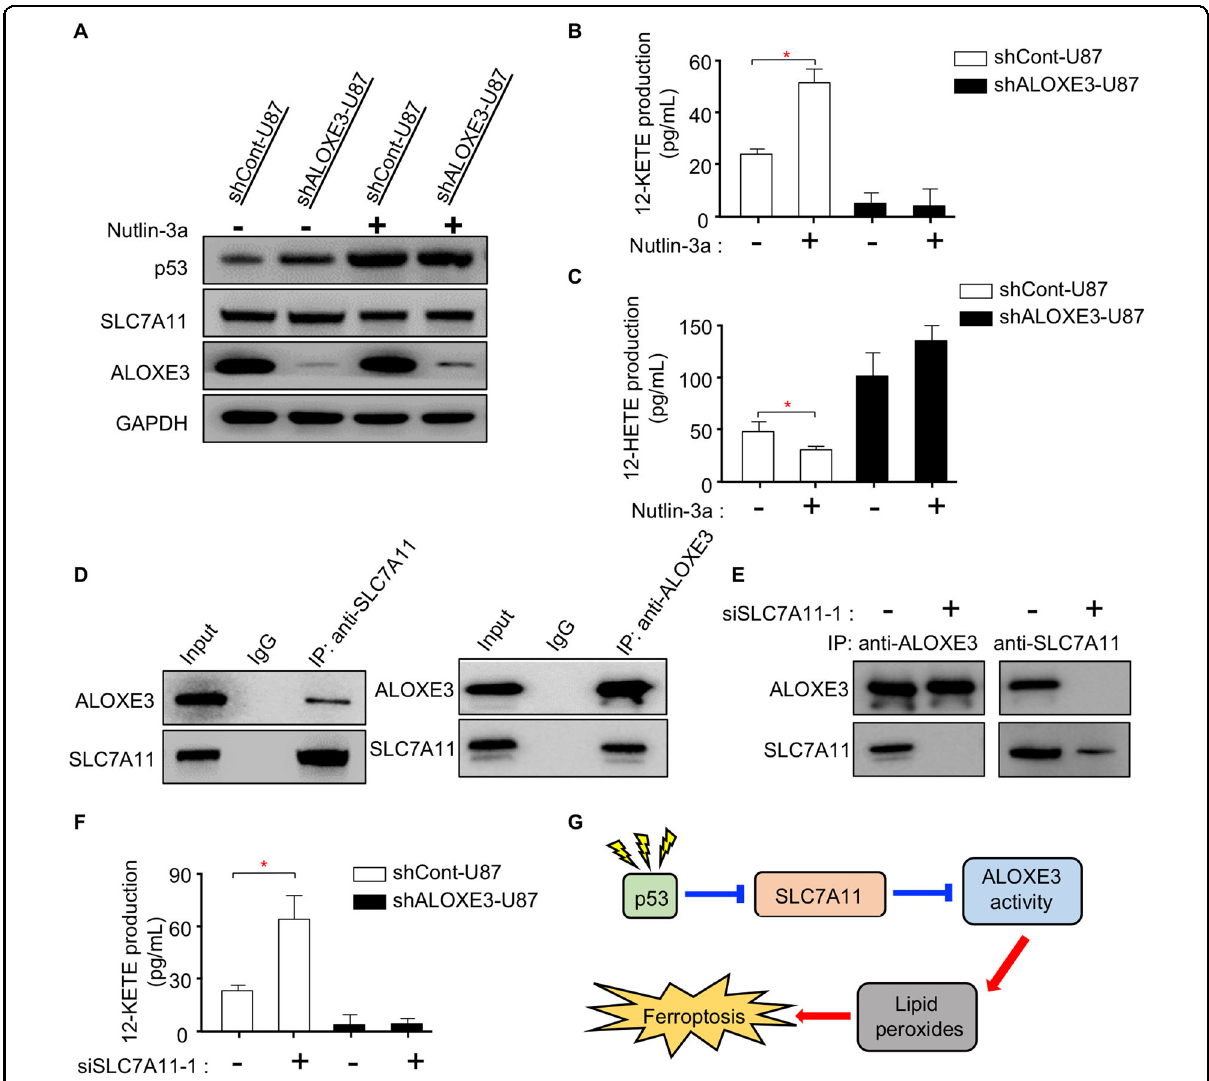
Fig. 4 p53 activates lipoxygenase activity of ALOXE3 through suppressing SLC7A11. A Immunoblotting analysis of p53, SLC7A11, ALOXE3, and GAPDH in shALOXE3-U87 and shCont-U87 cells with or without Nutlin-3a treatment. Representative immunoblot images are shown ( n = 6). B , C Levels of ( B ) 12-KETE and ( C ) 12-HETE in culture medium harvested from shALOXE3-U87 and shCont-U87 cells with or without Nutlin-3a treatment ( n = 6). D Western blot analysis of the endogenous interaction between ALOXE3 and SLC7A11 in U87 cells. E Western blot analysis of the endogenous interaction between ALOXE3 and SLC7A11 in U87 cells treated with siSLC7A11-1 or siCont. F 12-KETE levels of culture medium harvested from shALOXE3-U87 and shCont-U87 cells transfected with siSLC7A11-1 or siCont ( n = 6). G Mechanistic insight into p53-mediated activation of ALOXE3 activity and its associated ferroptosis. All data are represented as the mean ± s.e.m. * p < 0.05 (Student ’ s t